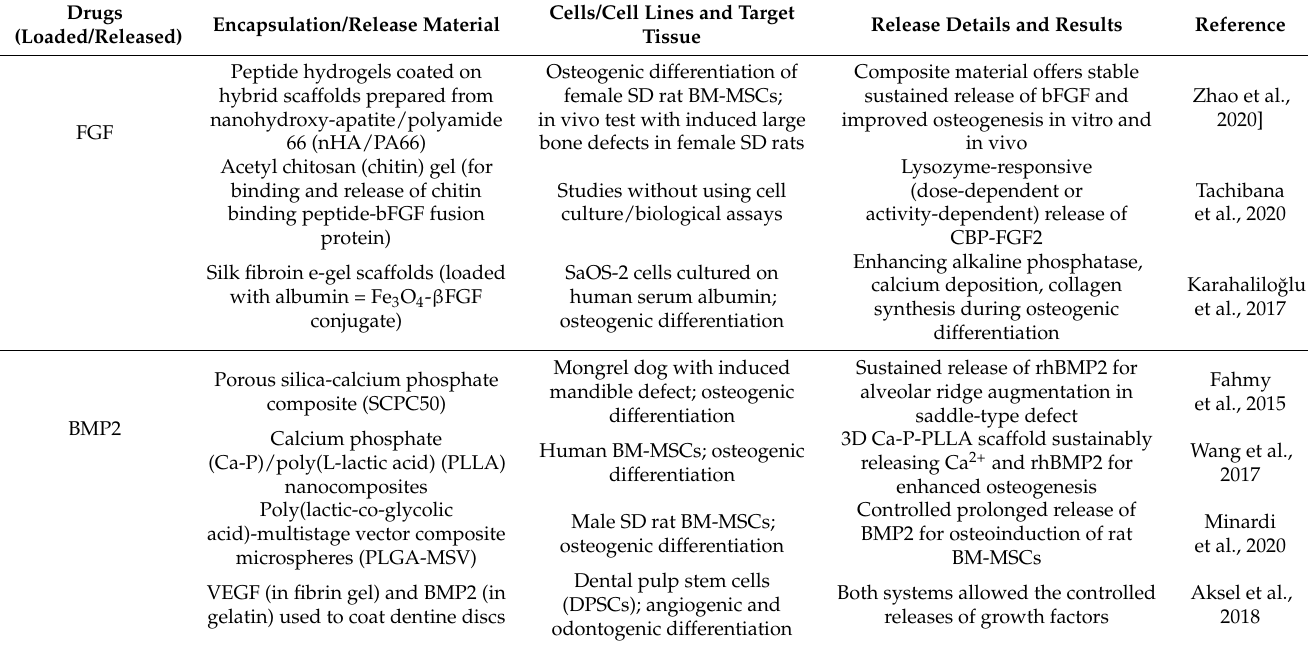
Table 2. Materials applicable for loading, encapsulation, and drugs/signaling molecules release for promoting osteogenic and angiogenic stem cell differentiation, proliferation, and growth. Adapted and extended based on Baranova 2020 [484]. Copyright MDPI